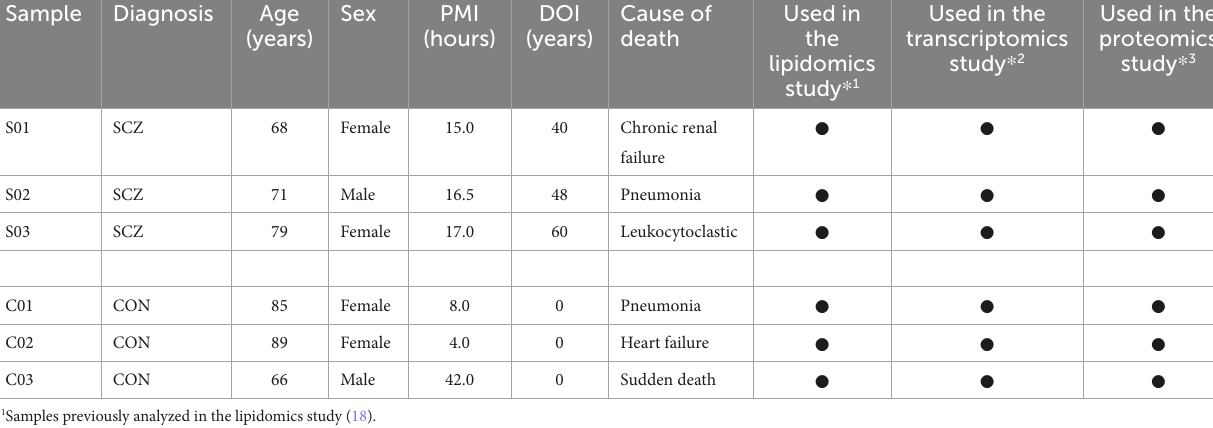
TABLE 1 Characteristics of subjects from whom postmortem brain samples were obtained.